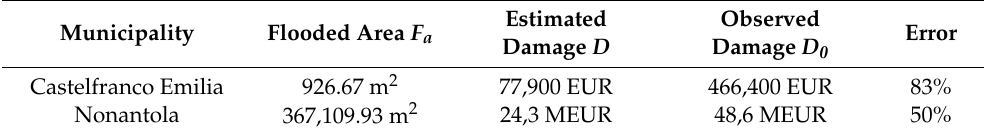
Table 2. Results of the model